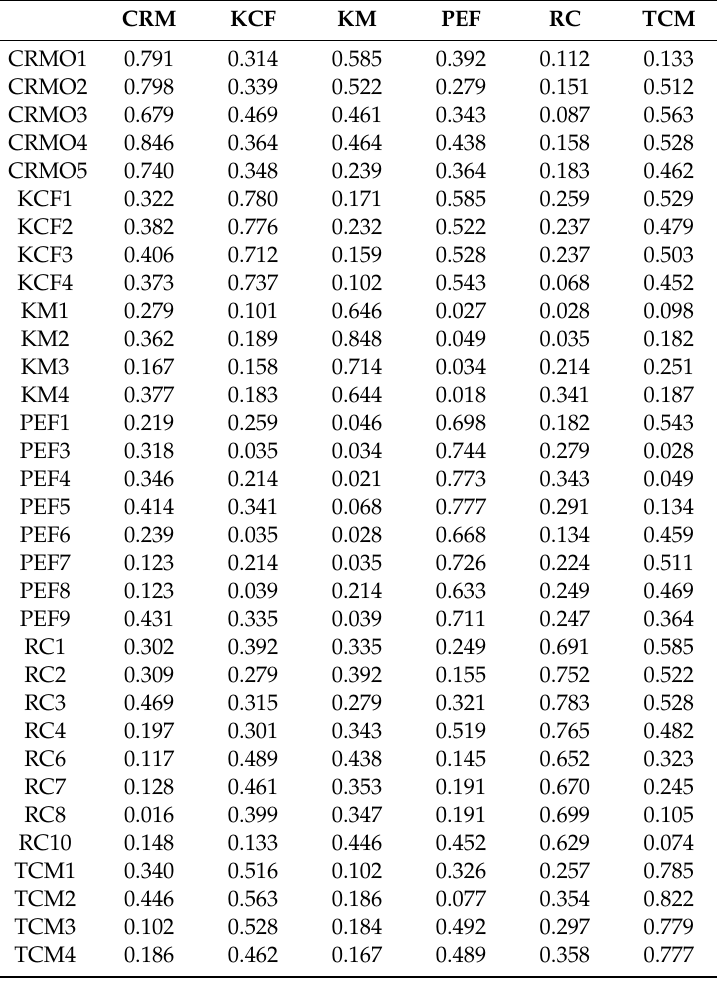
Table 2. Loadings and cross-loadings.